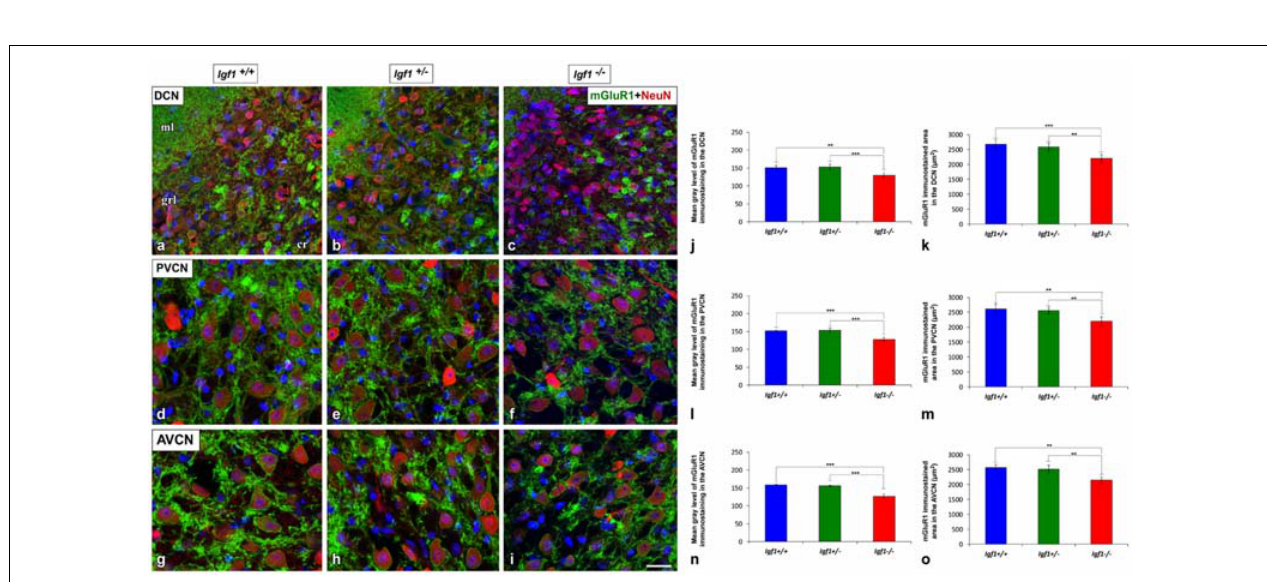
FIGURE 11 | Downregulation of mGluR1 α in the cochlear nuclei of Igf1 − / − mice. In the Igf1 − / − mice, there was less mGluR1 α staining (green) in the molecular and granule layers of the DCN than in the other genotypes (A–C) . Similar decreases were also detected in Igf1 − / − mouse PVCN (D–F) and AVCN (G–I) . Quantification confirmed these qualitative decreases in the Igf1 − / − mouse relative to the Igf1 + / + and Igf1 + / − mice (J–O) . The error bars indicate the standard deviations of the mean. Statistically significant differences among the animal groups were evaluated by one-factor ANOVA ( ∗∗ p < 0.01, ∗∗∗ p < 0.001). Neurons are stained with NeuN antibody (red) and cell nuclei are stained with DAPI (blue). Abbreviations: AVCN, anteroventral cochlear nucleus; cr, central region of the dorsal cochlear nucleus (DCN); grl, granule/fusiform layer; ml, molecular layer; mGluR1, metabotropic glutamate receptor 1; NeuN, neuronal marker; PVCN, posteroventral cochlear nucleus. Scale bar: 20 µ m in ( I ; it also applies to A–H